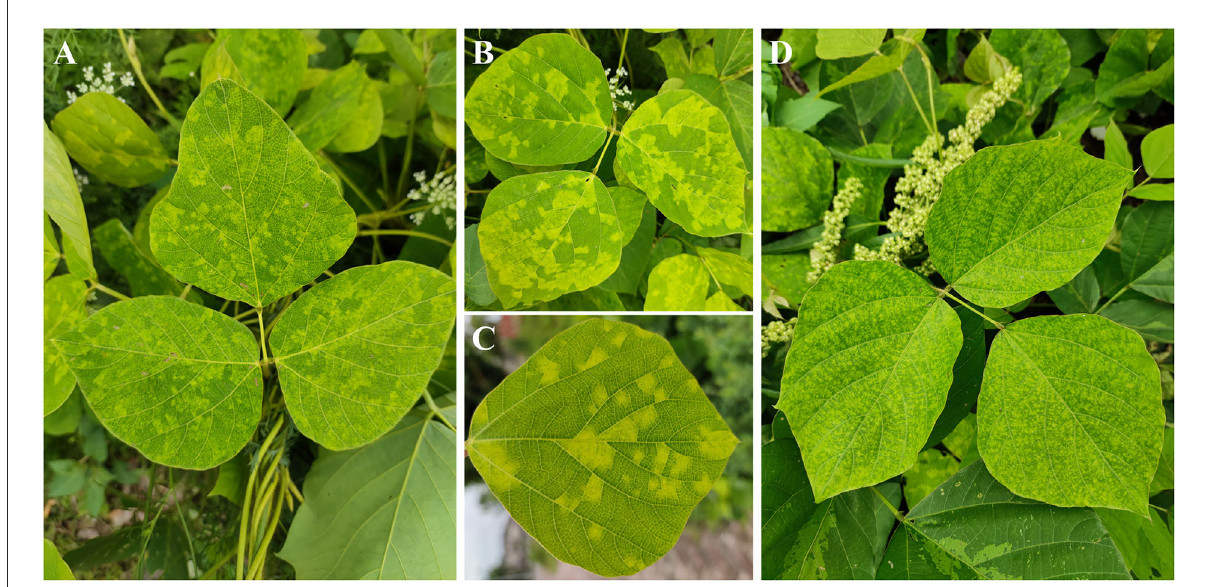
FIGURE1 Symptoms observed on leaves of Pueraria lobata with a mixed infection of PloAEV, PloACV, and KuMV-CQ. The symptoms include yellow spots (A) , mosaic (B,C) , and mottling (D)